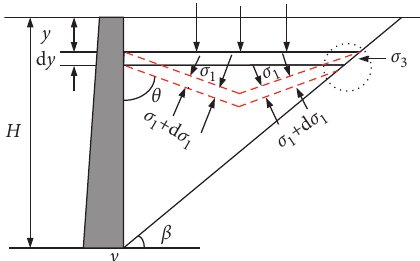
Figure 3: Simplified calculation model.